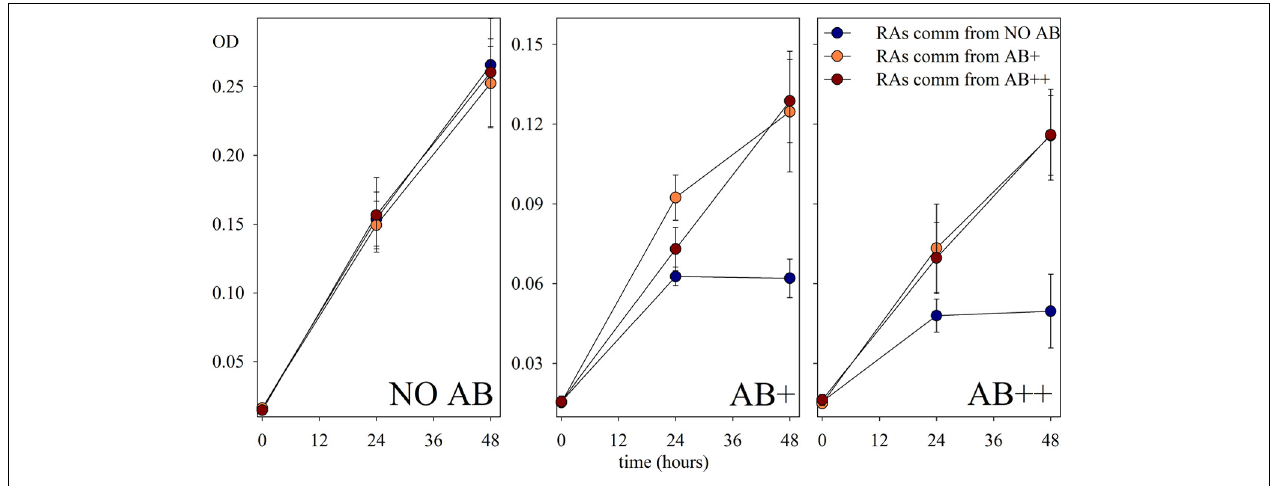
FIGURE 5 | Growth of the reassembled communities. Growth of communities reassembled (RAs comm) from the experimental strains at the end of the continuous culture treatments, and preferentially re-exposed to